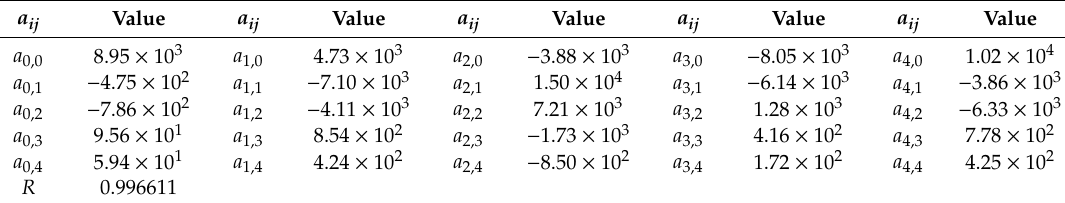
Figure 3. Experimental, approximated, and predicted flow curves of the examined Cr-Mo low-alloyed steel. ( a ) Strain rate of 0.02 s − 1 ; ( b ) strain rate of 0.2 s − 1 ; ( c ) strain rate of 2 s − 1 ; ( d ) strain rate of 20 s − 1 . Boxes–experiment; color solid lines–approximation; gray solid lines–prediction. Table 3. Material constants a ij of the polynomial M ( 𝜀,𝜀(cid:4662) ) (7).